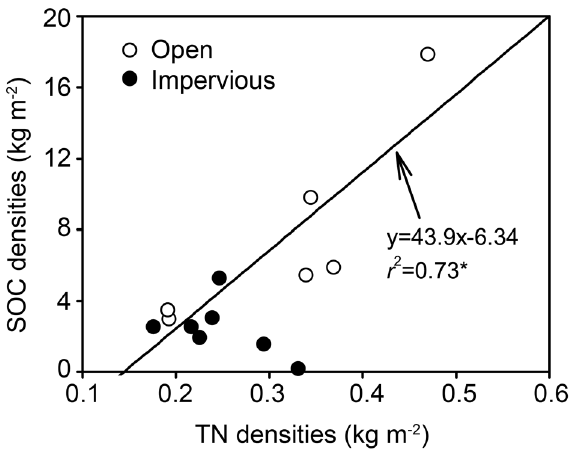
Figure 3. The correlations between the densities of SOC and TN for urban soils in Yixing city. SOC represents soil organic carbon, and TN represents total nitrogen, * P , 0.05 ( n =7 for urban impervious- covered soils, and n =6 for urban open